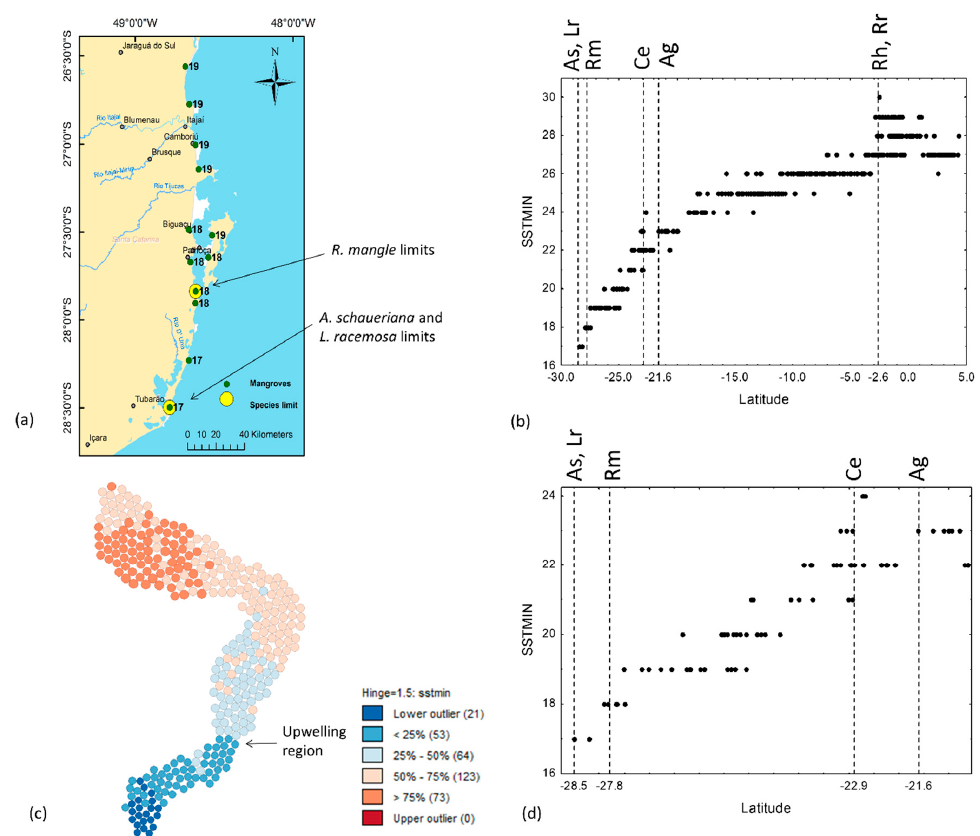
Figure 6. Detailed description of the Min sea surface temperature (SSTMIN) (°C) for mangroves in Brazil. ( a ) Detailed map of the south limits with their SSTMIN values for each location of mangroves; ( b ) Scatterplot ( n = 334) representing the SSTMIN by latitude in decimal degree superimposed on species distribution limits (vertical dashed lines); ( c ) Cartogram map distorted by the high and low values of SSTMIN; ( d ) Scatterplot of SSTMIN with a detailed zoom of the surrounding area of the southernmost species distribution limits (vertical dashed lines of the species limits). Refer to Figure 5 for further explanations. Table 3. An overview of values of air temperature derivate and sea surface temperature derivate according to punctual values at latitudinal species limits and their species richness values for each limit. SPECIES Species Latitude Richness BIO1